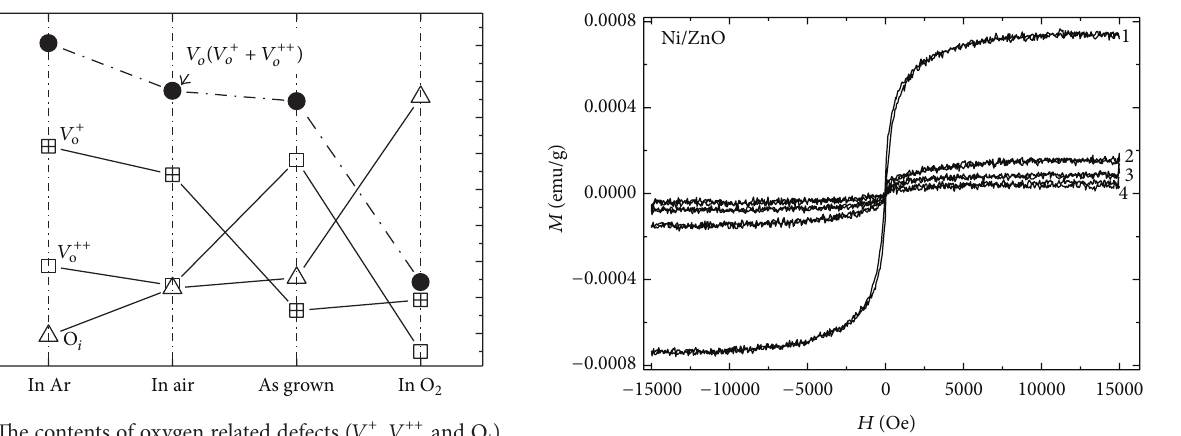
Figure 4: The contents of oxygen related defects ( 𝑉 + 𝑜 , 𝑉 ++ 𝑜 and O 𝑖 ) in as grown Ni doped ZnO nanoparticles, and samples with thermal annealing in O 2 , air, and Ar, respectively.